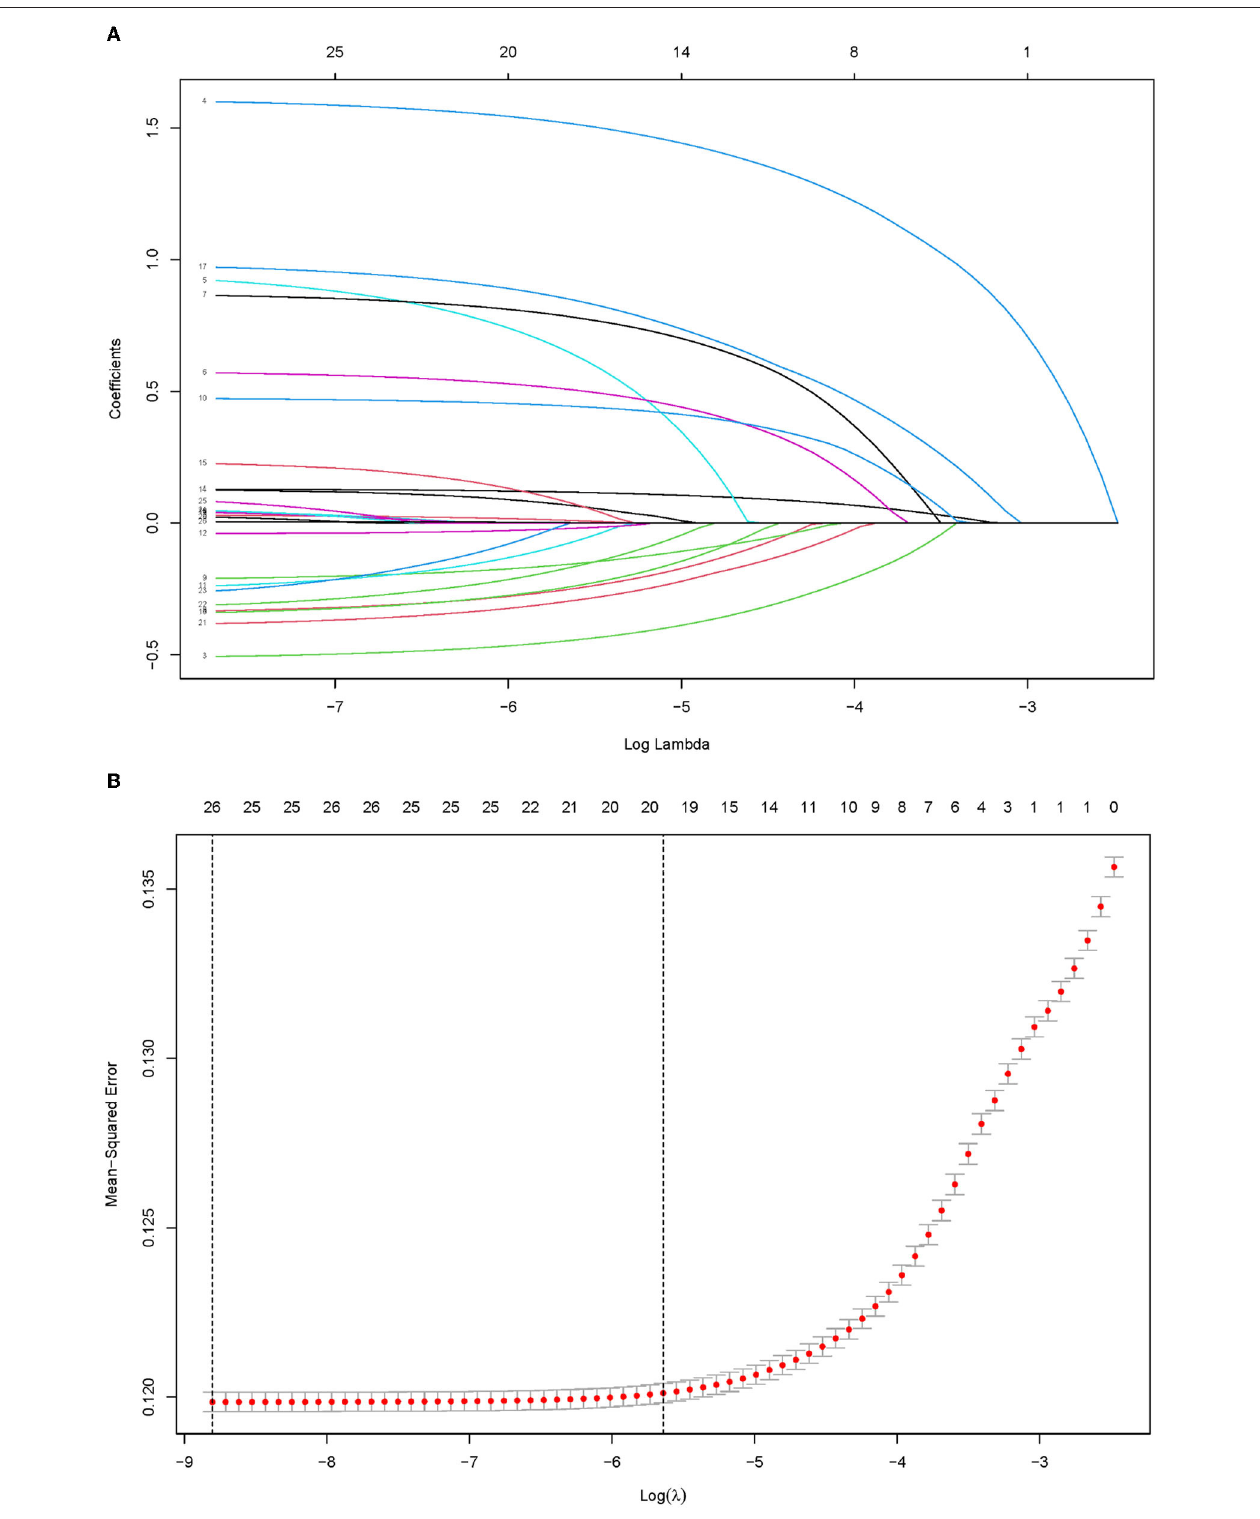
FIGURE 1 | Predictor selection using the Lasso binary logistic regression model. A Lasso coefficient of the total 14 predictors. (A) Lasso coefficient profiles of all predictors, a coefficient profile plot was provided against the log (Lambda) sequence. (B) Predictors selection by Lasso via minimum criteria, predictor selection in the Lasso model used 10-fold cross-validation via minimum criteria. Red-dotted vertical lines were drawn at the optimal values by using the minimum criteria (minimizing the mean-squared error), the value 9 represents that those 14 predictors were reduced to 9 non-zero features by Lasso.